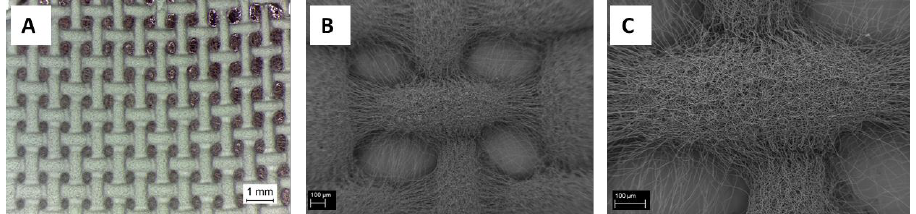
Figure 5. Light microscope image of PCL microfibers pattern ( A ). SEM micrographs of PCL microfibers pattern exhibiting large porosity at different magnifications: 100× (scale bar 100 μm) ( B ); and 200× (scale bar 100 μm) ( C ).